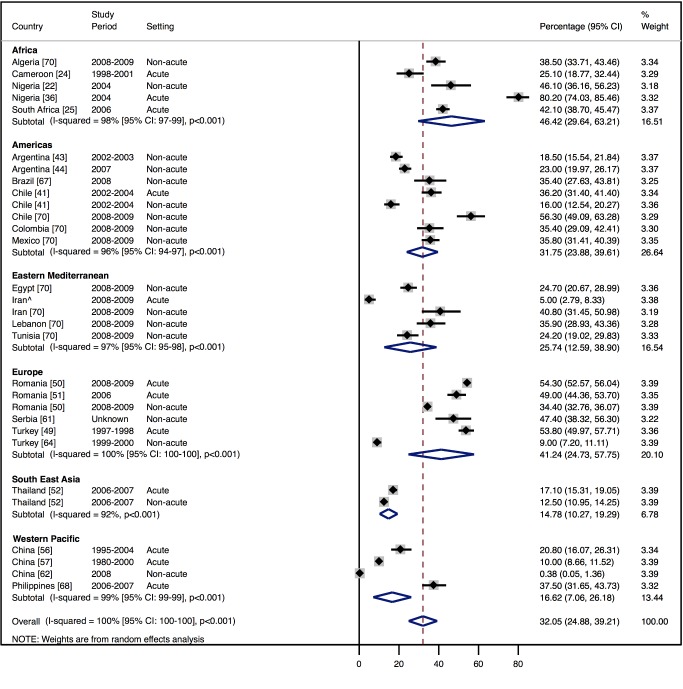
Mineralocorticoid receptor antagonist use by region.∧Rahimzadeh S, Farzadfar F, Ghaziani M (2013) Iranian hospital data project (unpublished data).